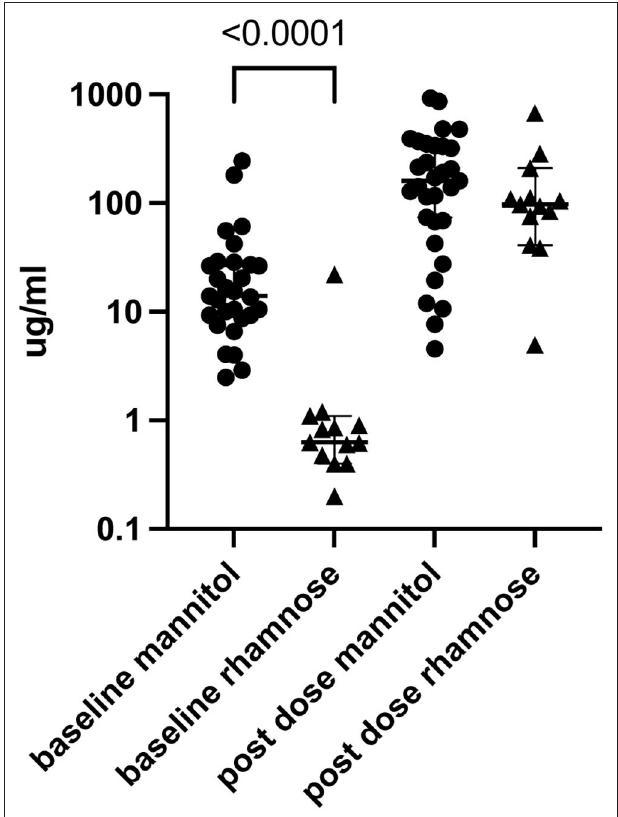
FIGURE 3 | Urine M ( n = 29) and R ( n = 13) before and after dual sugar testing. Only participants who produced pre-dose urine and in whom baseline circulating concentrations were detected are shown. Lines show median and